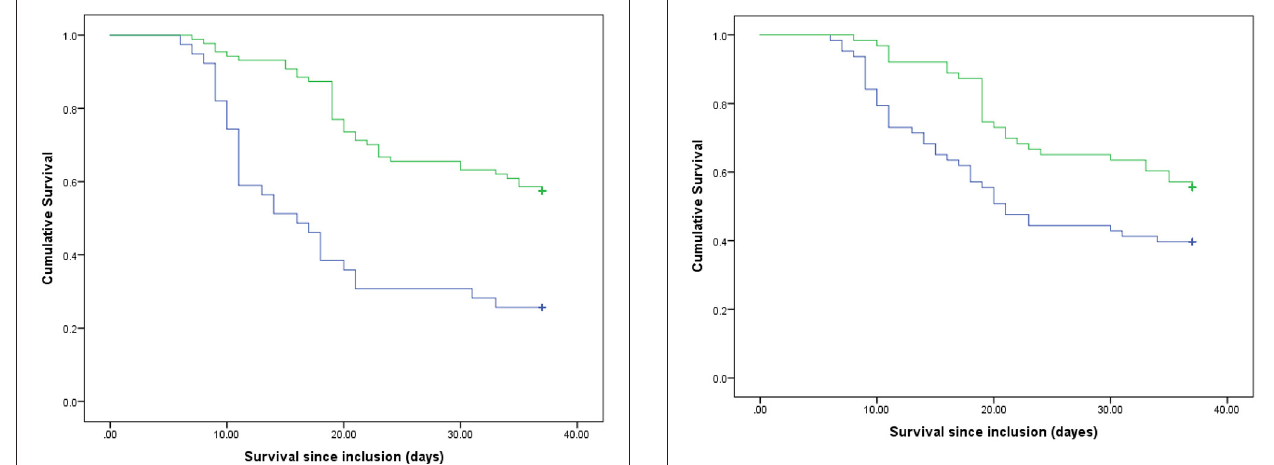
FIGURE 1 | Survival rates of the participants compared between two groups of the protein intake ratio. Blue line, patients with lower than median of the protein intake ratio; green line, patients with higher than median of the protein intake ratio. p < 0.001 (log rank).